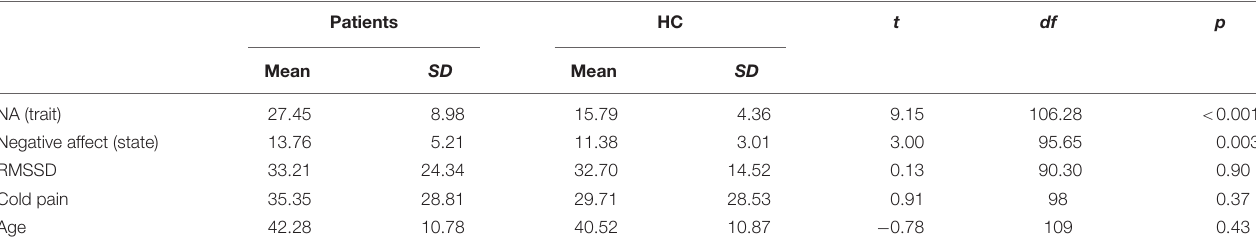
TABLE 1 | Means and standards deviations for patients and HC for NA, RMSSD, cold pain, and age.